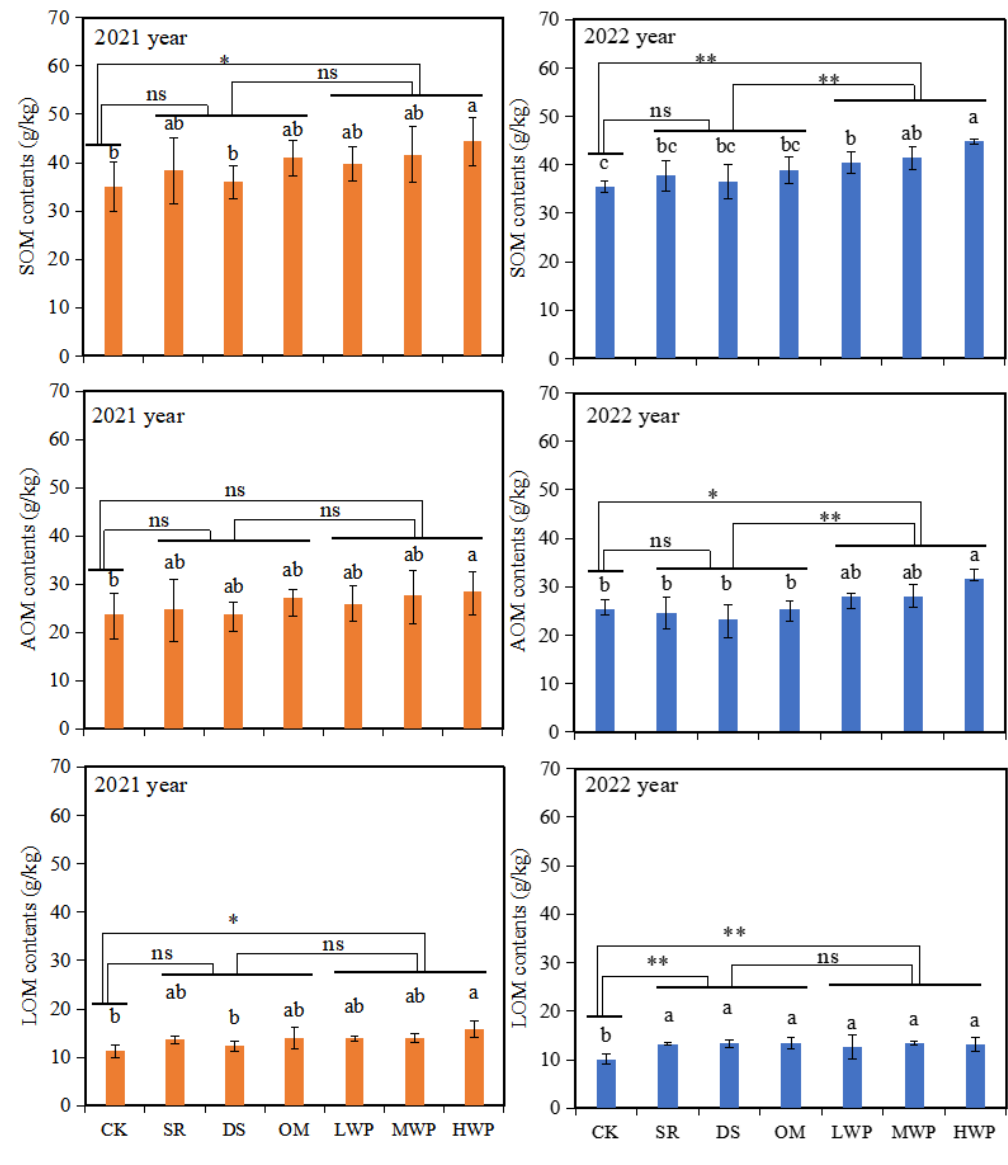
Figure 1. Changes in soil organic matter (SOM), labile organic matter (LOM), and recalcitrant organic matter (AOM) contents under different treatments. Vertical bars denote the standard error of the mean ( n = 3). Different letters, a, b, and c, indicate significant differences between treatments for the same histogram at p < 0.05. Significant differences among CK, conventional soil fertility-improving practices (SR, DS, and OM treatments), and natural humus material-adding treatments (LWP, MWP, and HWP) are indicated by * p < 0.05 and ** p < 0.01. ns represents no statistical significance at the p ≥ 0.05 level.